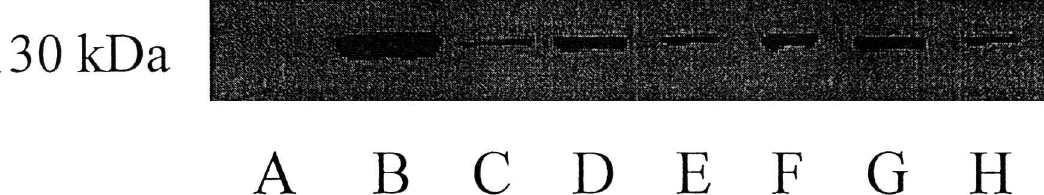
FIG. 3. Effect of tyrphostin AG126 (30 m M; lane H) or genistein (100 m M; lane G), rotenone (30 m M; lane F), pyrrolidine dithiocarbamate (25 m M; lane E), calpain inhibitor I (30 m M; lane D) or L-1-tosylamido-2- phenylethylchloromethyl ketone (30 m M; lane C) on the expression of iNOS protein in J774.2 macrophages caused by LPS (1 m g/ml; lane B) within 24h, as determined by Western (immuno)blot analysis. There was no iNOS protein detectable by the specific antibody against iNOS protein in unstimulated control macrophages (lane A). This immunoblot is representative for three separate experiments.